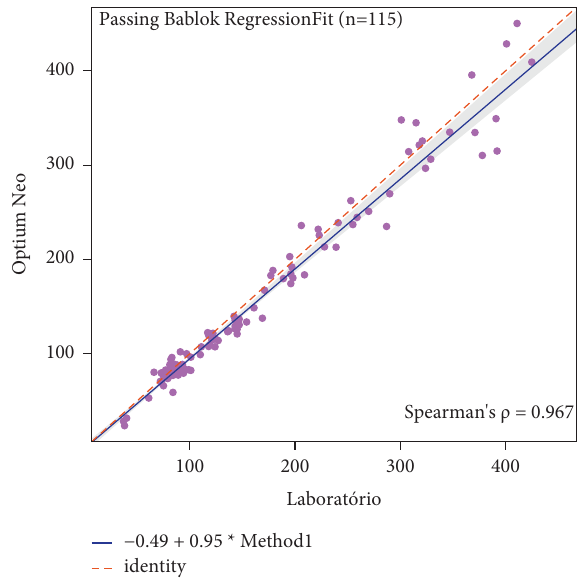
Figure 4: Passing-Bablok regression for the FreeStyle Optium Neo ®